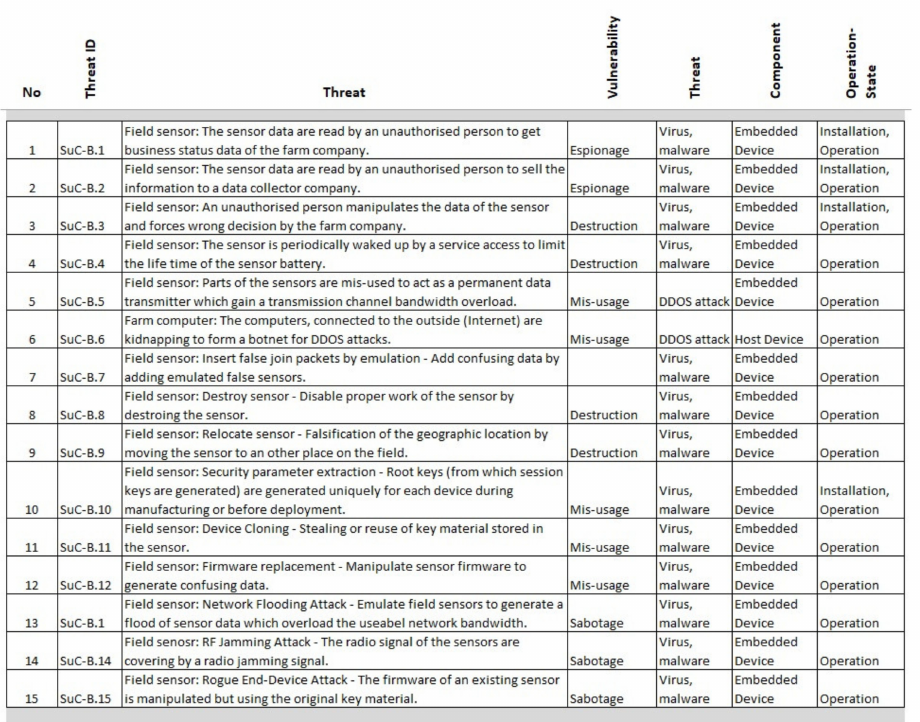
Figure 5. Cybersecurity risk analysis table, Part A.